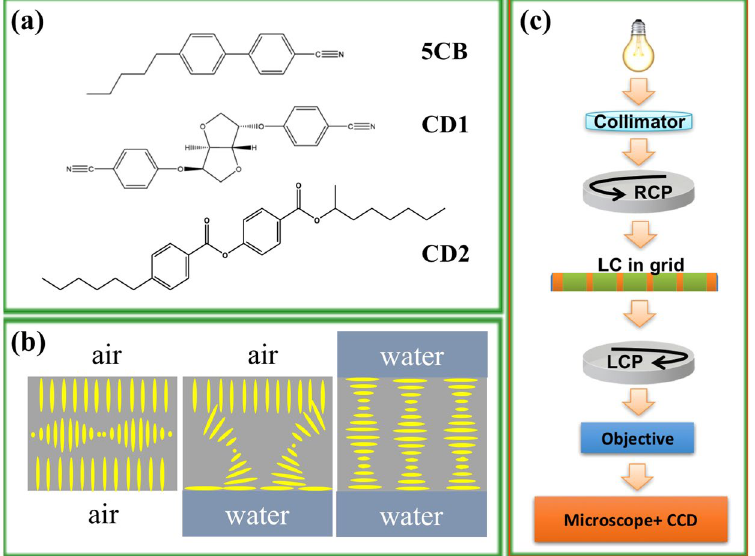
Figure 1. Studied materials and details of the experimental set-up. ( a ) Chemical structures of the host liquid crystal 5CB and chiral dopants CD1 and CD2, respectively; ( b ) Depictions of the configurations of the liquid crystal when bounded by air on both sides (homeotropic), water on one side and air on the other (hybrid), and water on both sides (planar); ( c ) Sketch of the experimental setup including the light beam, circular polarizers, a grid containing the LC film, and image acquisition using a CCD camera mounted on an inverted